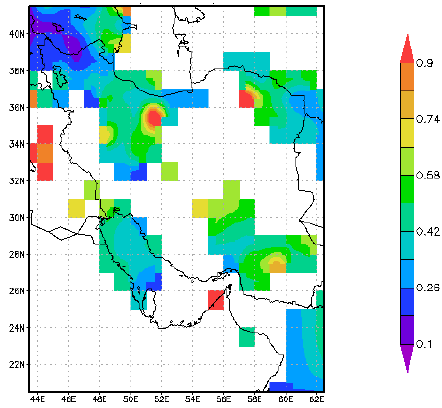
Table 1. Asia - Peak gusts [m/s]